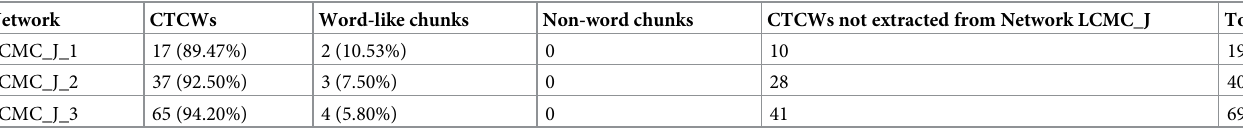
Table 2. Basic information of TNIs extracted from three sub-networks of Network